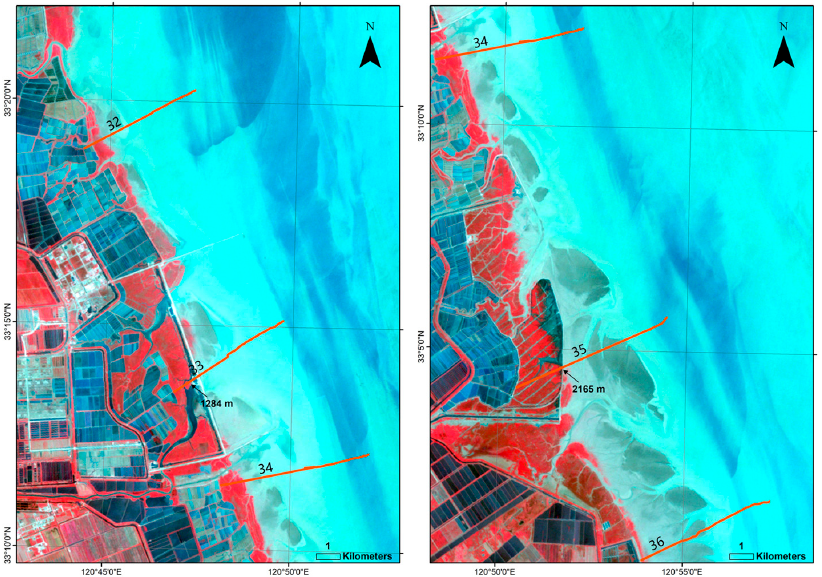
Figure 11. Satellite images of the JD 33 and 35 from Landsat 7 ETM on 5 July 2008 (arrows indicate the location of new dykes on each profile and distance to the old dykes).